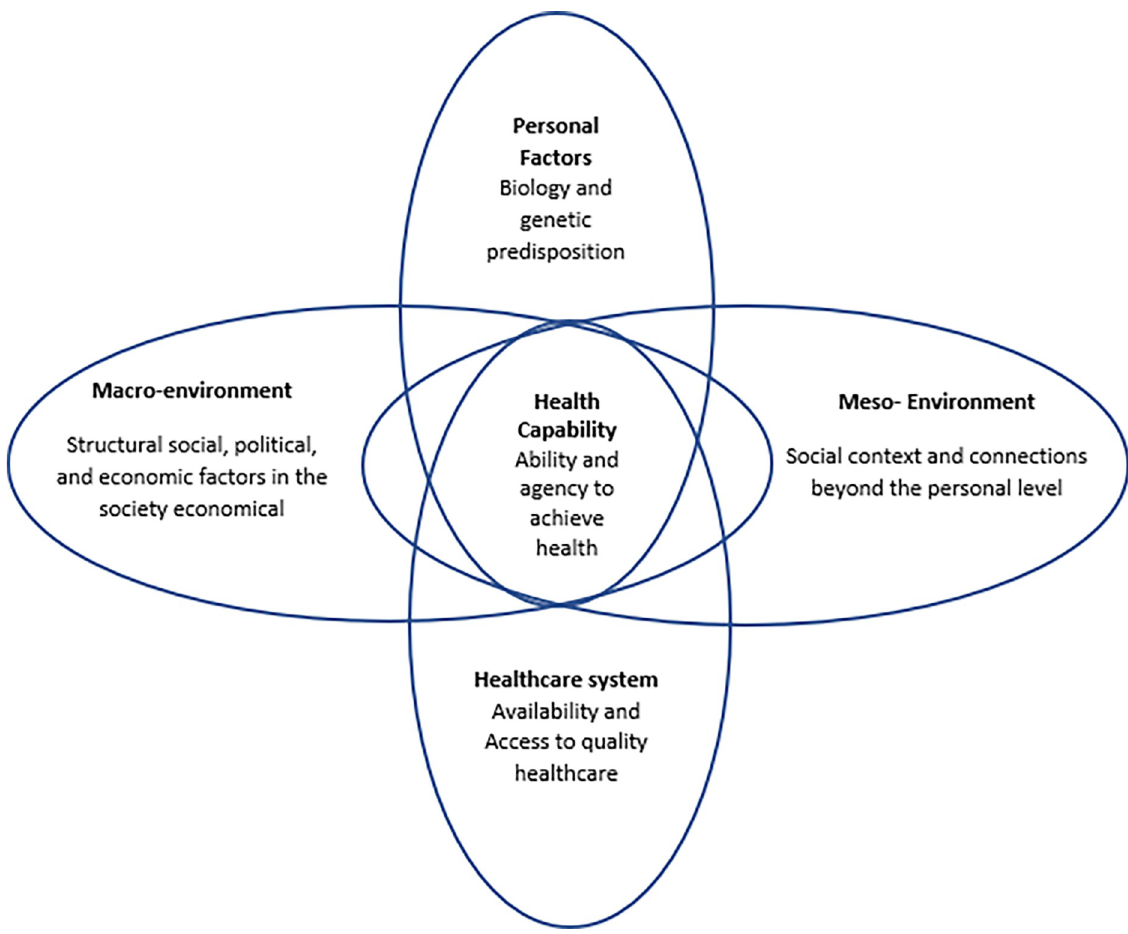
Fig 3. Health capability model adapted